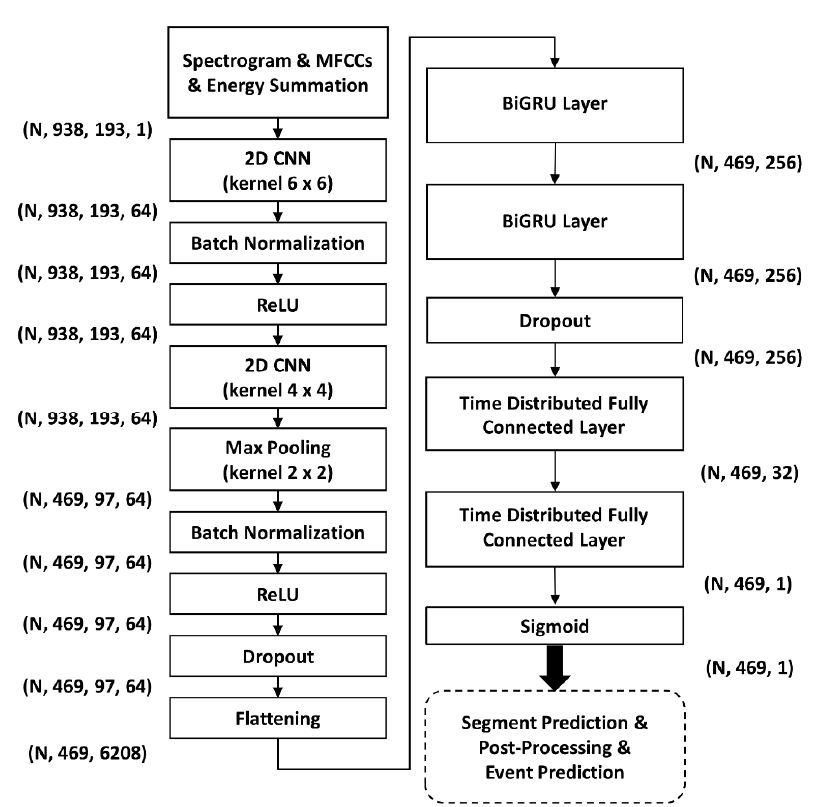
Figure 3. Architecture of the CNN–BiGRU model. This figure is adapted from our previous